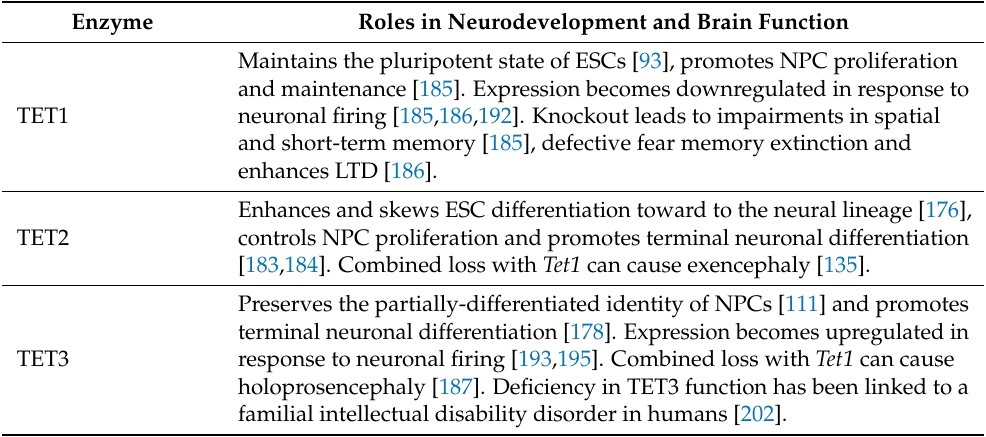
Table 2. The TET Enzymes and Their Roles in Neurodevelopment and Brain Function. Enzyme Roles in Neurodevelopment and Brain